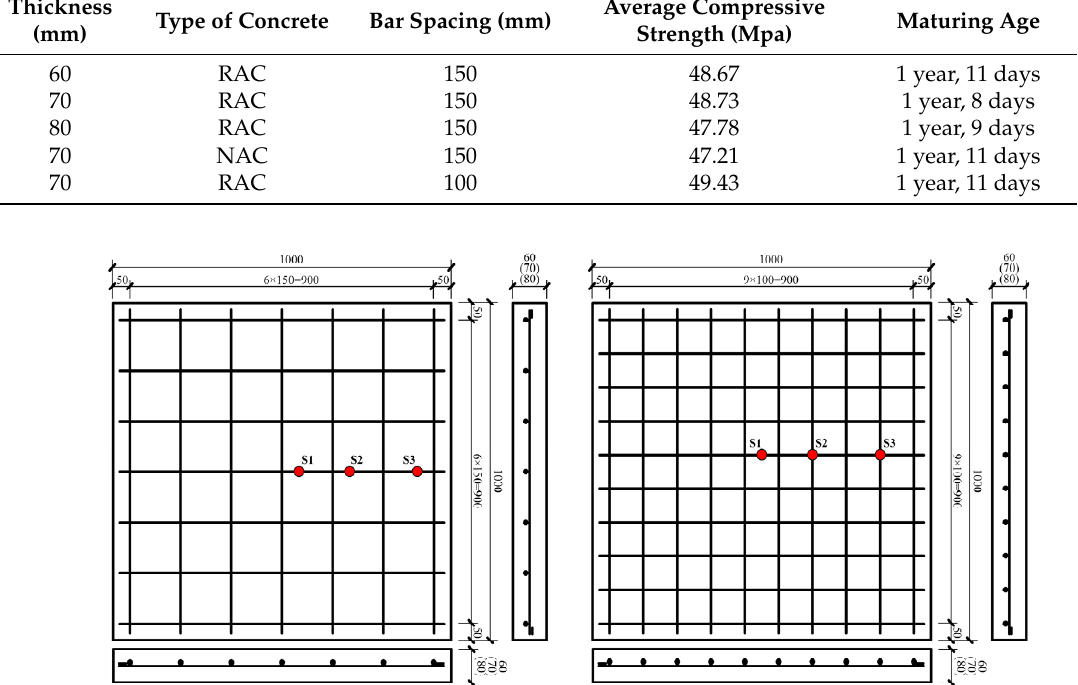
Figure 2. Size and reinforcement layout of RCP specimen